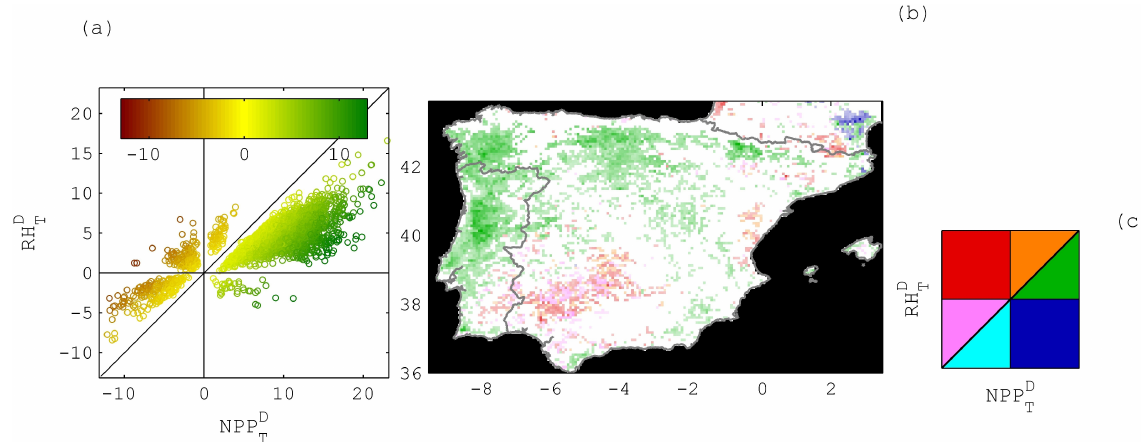
Fig. 9. Decomposition of NEP D trends into R D distribution of the underlying NPP D position in (a) following the diagram in (c) . The colour intensity in (b) is proportional to the magnitude of NEP D